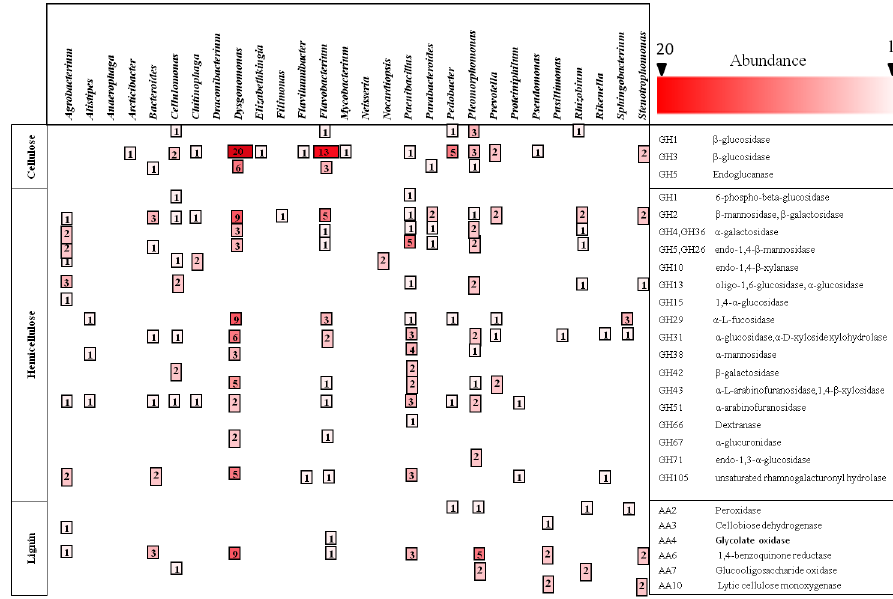
Figure 5. Degradation-related gene of corn stover of